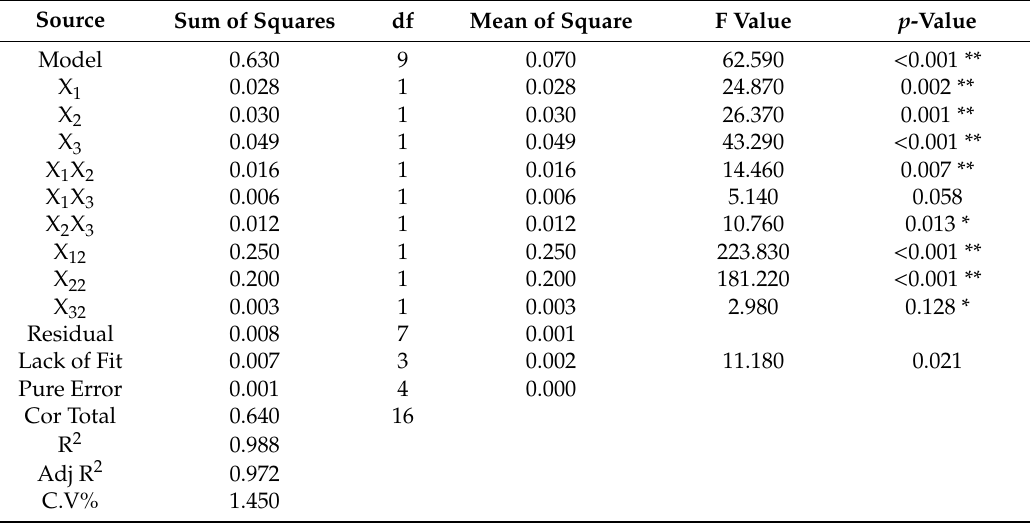
Table 2. F-test and ANOVA analysis of the response surface quadratic